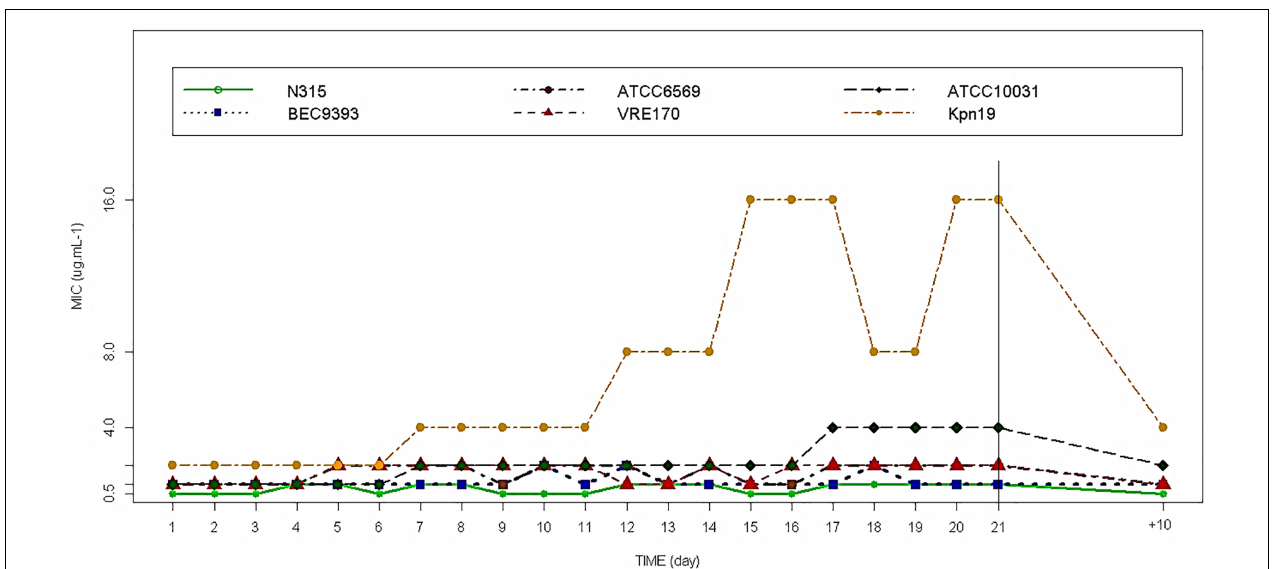
FIGURE 1 | Resistance development of S. aureus, E. faecium and K. pneumoniae during 21 serial passages in Fluopsin C-containing MHB (FC-RM21) and the final MIC, when the mutants were serially passaged for 10 days in Fluopsin C-free medium (FC-RM + 10).